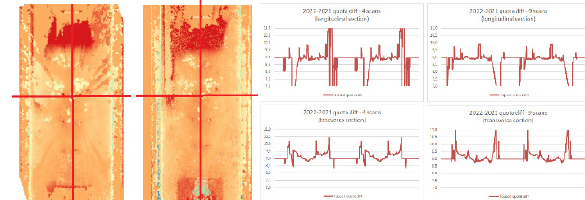
Figure 12 . Height differences between full resolution model and (left) 4 scans model (right) 9 scans model.